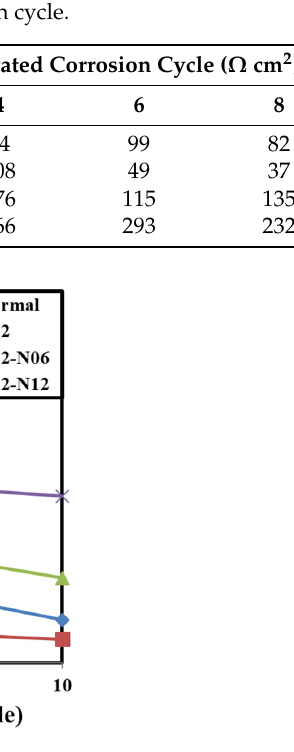
Figure 8. Variation in R p with accelerated corrosion cycle.